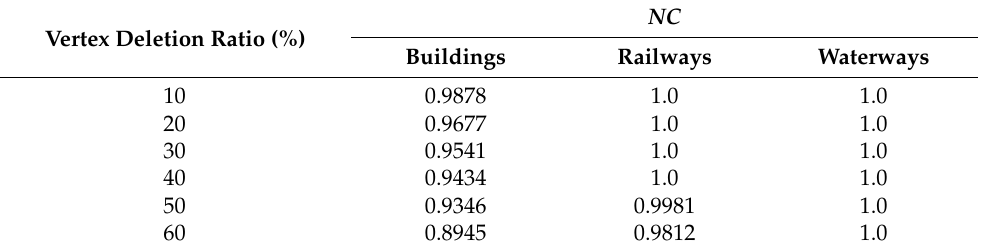
Table 8. The robustness results of vertex deletion attack.